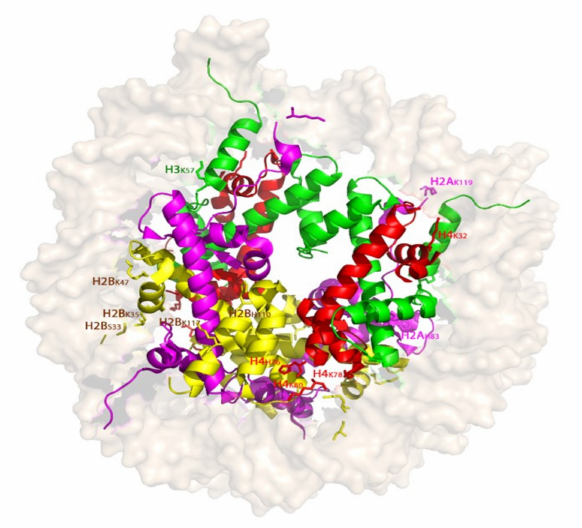
Figure 4. Depiction of the nucleosome, showing the surface exposure of the amino acids found to form adducts with nevirapine. The structure was obtained from PDB